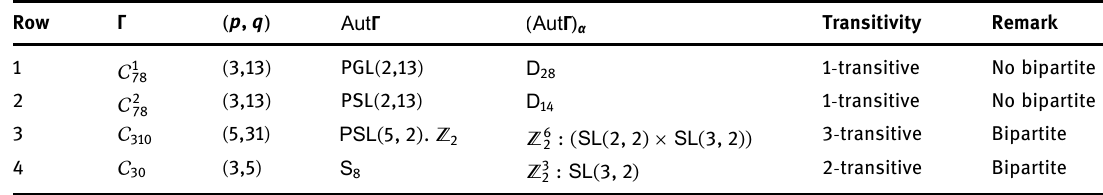
Table 1: Connected 7 - valent symmetric graphs of order 2